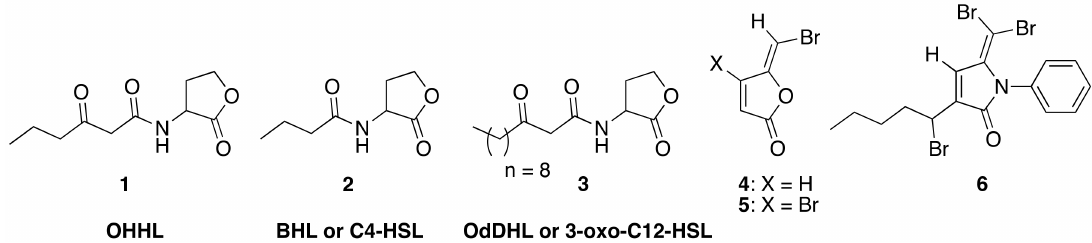
Figure 1. Bacterial N -acylated homoserine lactones (AHLs) used for QS and synthetic QS inhibition. P. aeruginosa is an opportunistic and ubiquitous human pathogen and is amongst the most common causative agents of nosocomial and life-threatening infections [6]. In P. aeruginosa , QS is coordinated via a triumvirate of LuxR homologues, namely the LasR, RhlR and QscR systems [7]. These overlapping receptors have significant roles in the regulation of gene expression and QS